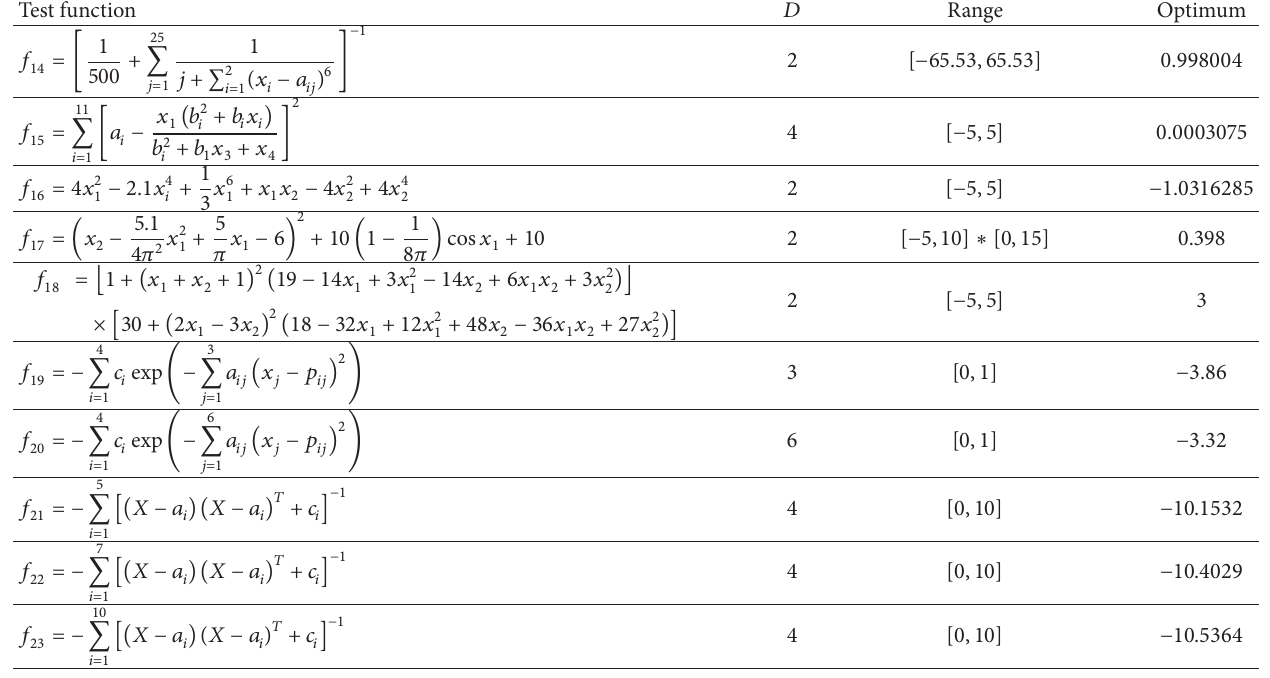
Table 2: Benchmark functions based on our experimental study for fixed function.